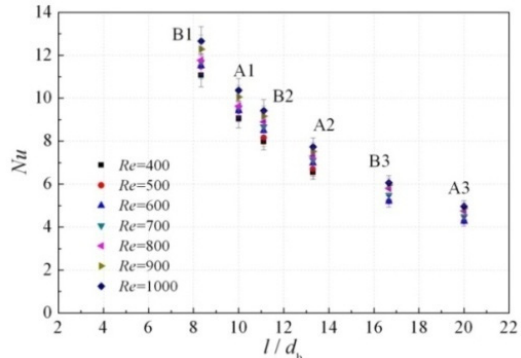
Figure 7. Nusselt number variation with l / d h , Va = 250.